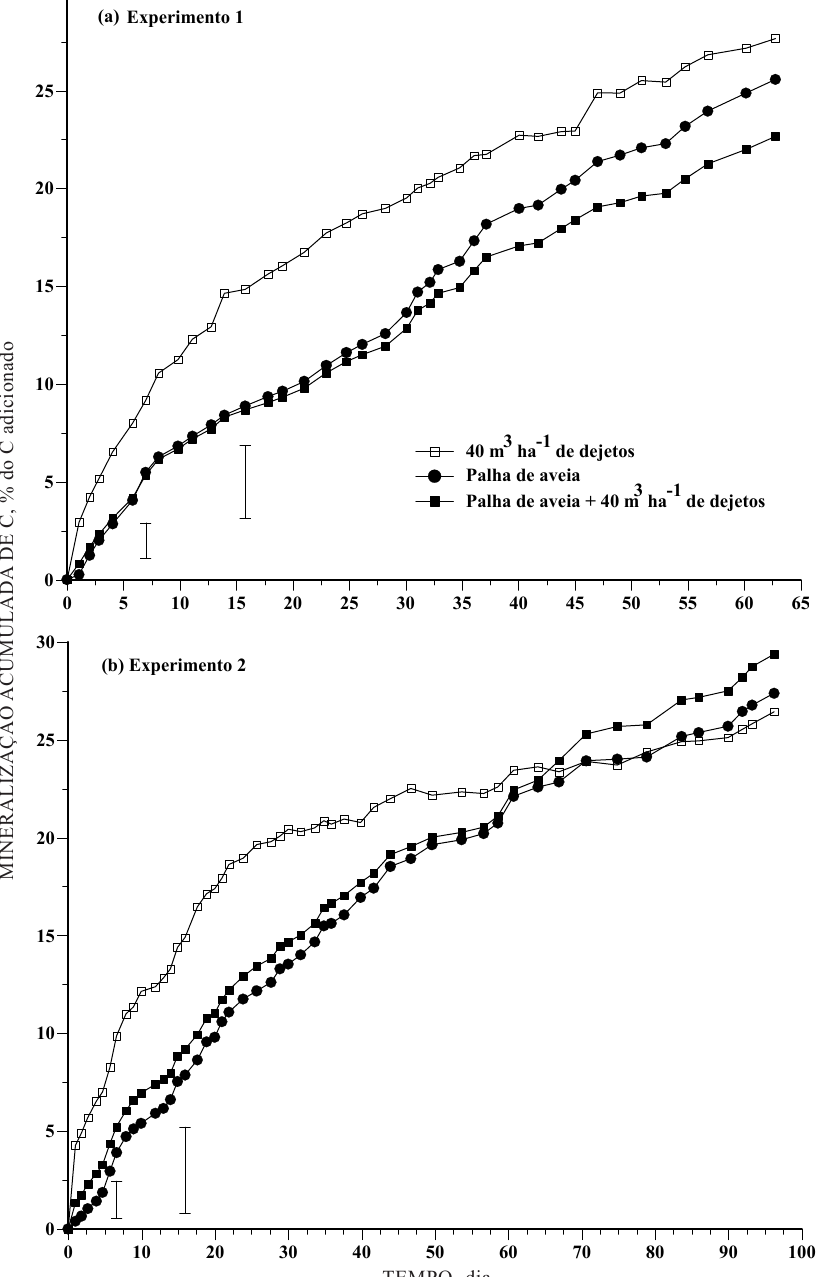
Figura 4. Mineralização acumulada do C (% do C adicionado) proveniente dos dejetos, da palha de aveia e da mistura de dejetos e palha, nos experimentos 1 (a) e 2 (b). As barras verticais indicam a diferença mínima significativa (Tukey a 5 %) em datas de avaliação, escolhidas